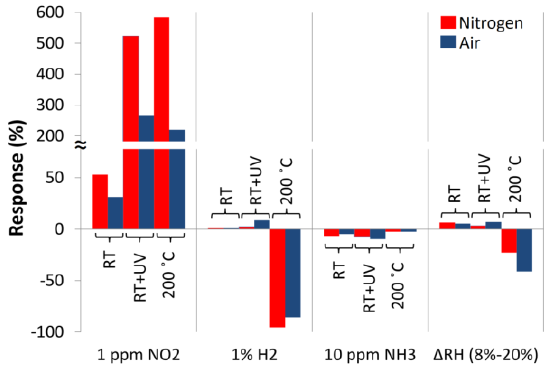
Figure 16. Comparison of the sensitivity of ZnO nanostructures to the action of selected gases.